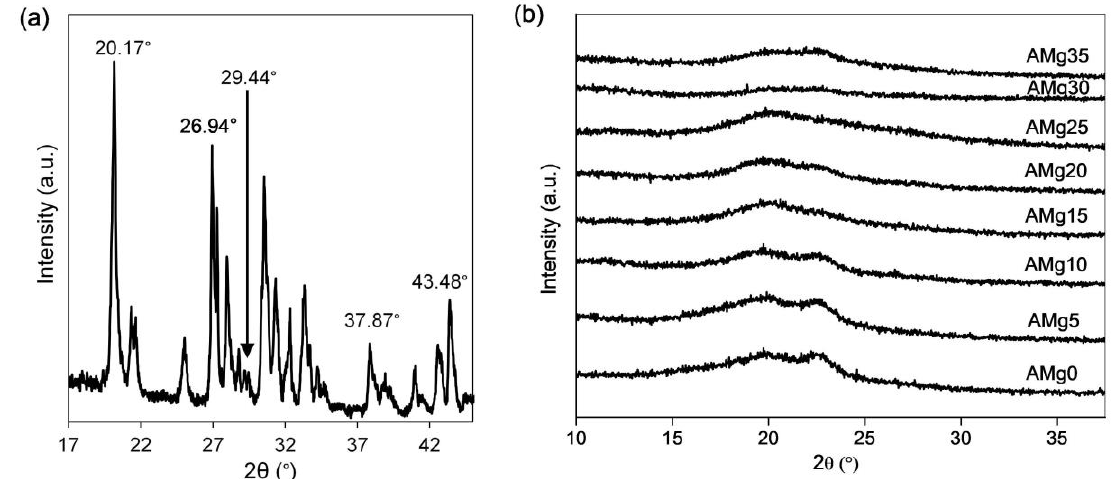
Figure 8. XRD patterns of ( a ) Mg(NO 3 ) 2 in range of 2 θ = 17 ◦ − 45 ◦ and ( b ) various weight percentage of Mg(NO 3 ) 2 incorporates into agarose–based polymer electrolyte between 2 θ = 10 ◦ − 37 ◦